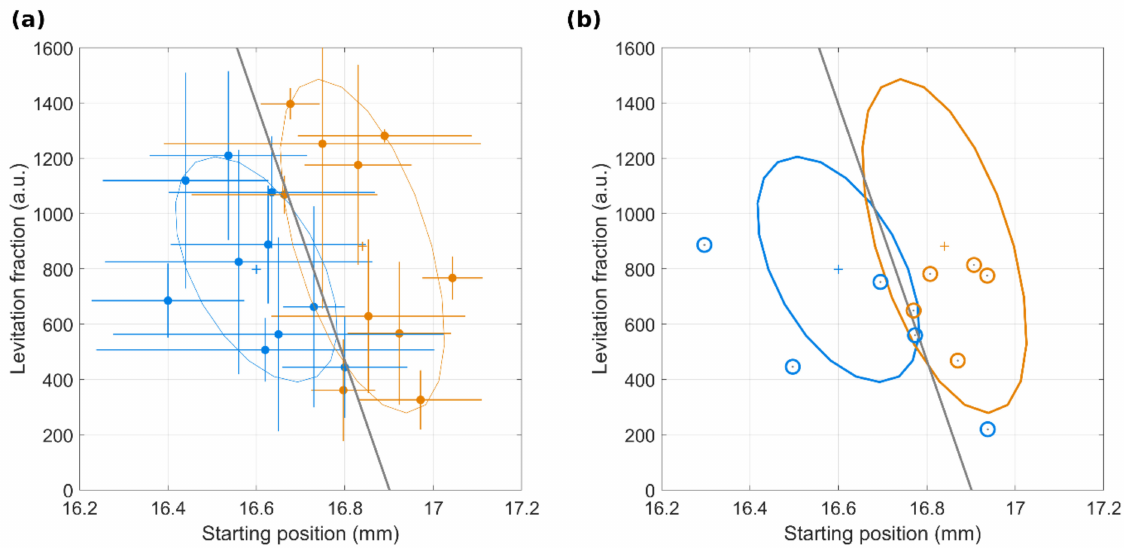
Figure 4. ( a ) Scatter plot of the MagLev pattern’s starting position and levitating population area for a training set of N C = 10 NOP samples (blue dots) and N P = 10 PDAC samples (orange dots) and corresponding experimental errors. Crosses indicate the average positions, ellipses the distribution extensions and the black line is the output of a linear discriminant analysis (LDA). By LDA computation, the resulting test’s parameters read specificity = 100%, sensitivity = 80%, global accuracy 90%. ( b ) Output of a validation blind test superimposed to the distributions of the training dataset (ellipses) and the outcome of the linear discriminant analysis (black line). N C = 5 NOP samples (blue circles), N p = 5 PDAC sample (orange